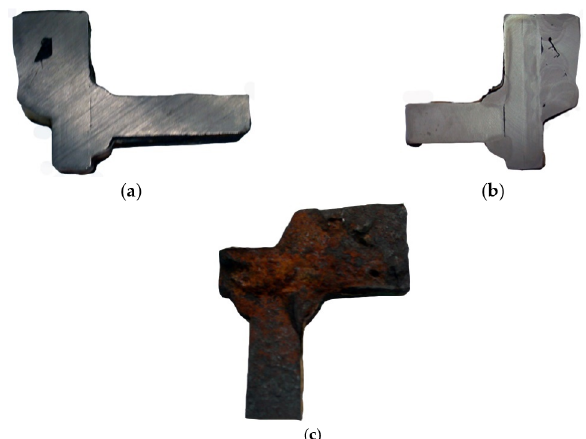
Figure 36. Macroscopic examination (handy-size bulk carrier 30185 DWT): ( a ) the lateral surface of the bar containing crack I; ( b ) view of the second side surface of the bar after etching; and ( c ) fracture